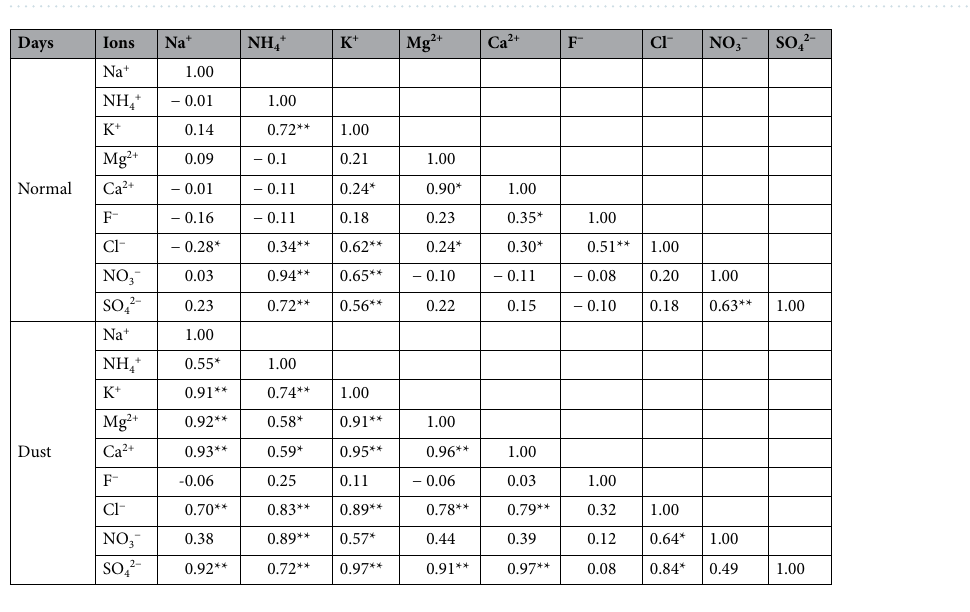
Table 2. Pearson correlations between water-soluble ions for normal and dust storm days from March 1, 2021, to May 31, 2021 in Lanzhou, China. * p < 0.05; ** p <